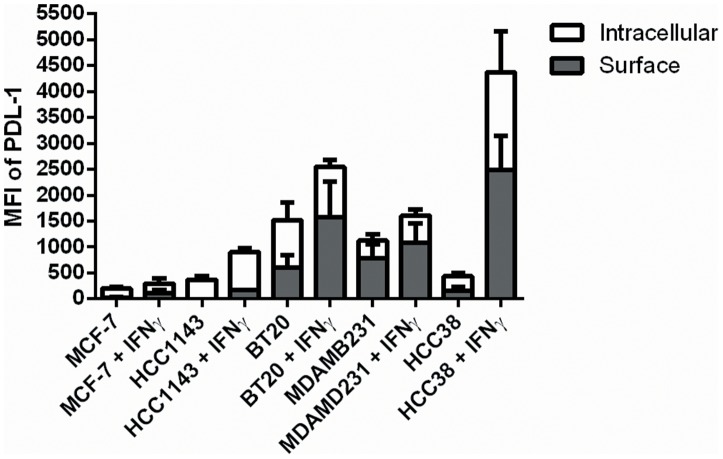
PD-L1 protein localization at baseline and post IFNγ treatment.PD-L1 protein expression increases with treatment, but there does not appear to be a major shift in protein localization patterns (proportion of surface vs. surface+intracellular) between the different cell lines and molecular subtypes.